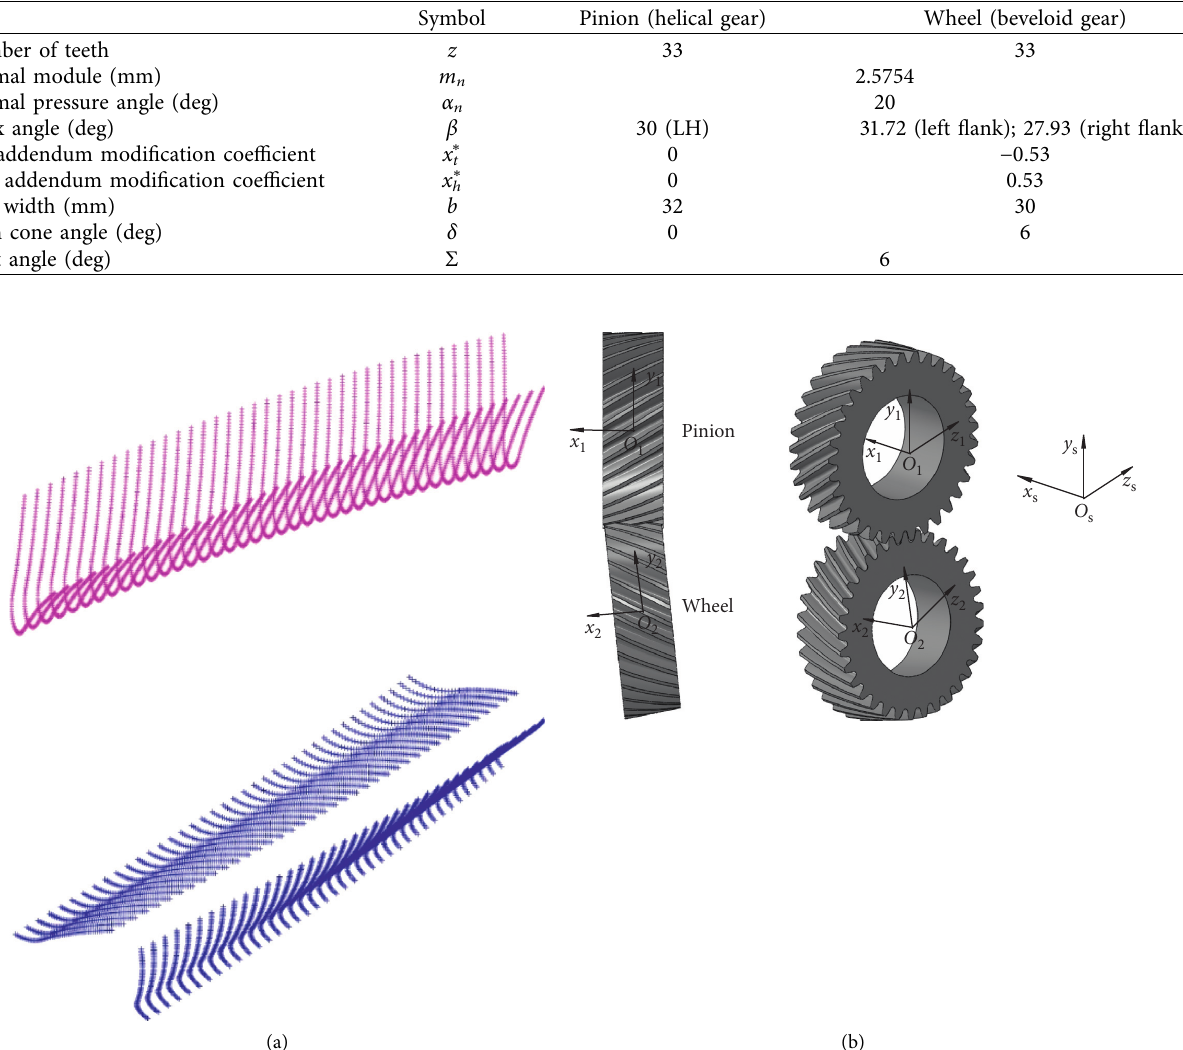
Figure 5: Geometry model of shaft intersecting beveloid gear pair. (a) Points set of tooth surfaces. (b) Beveloid gear pair 3D model.